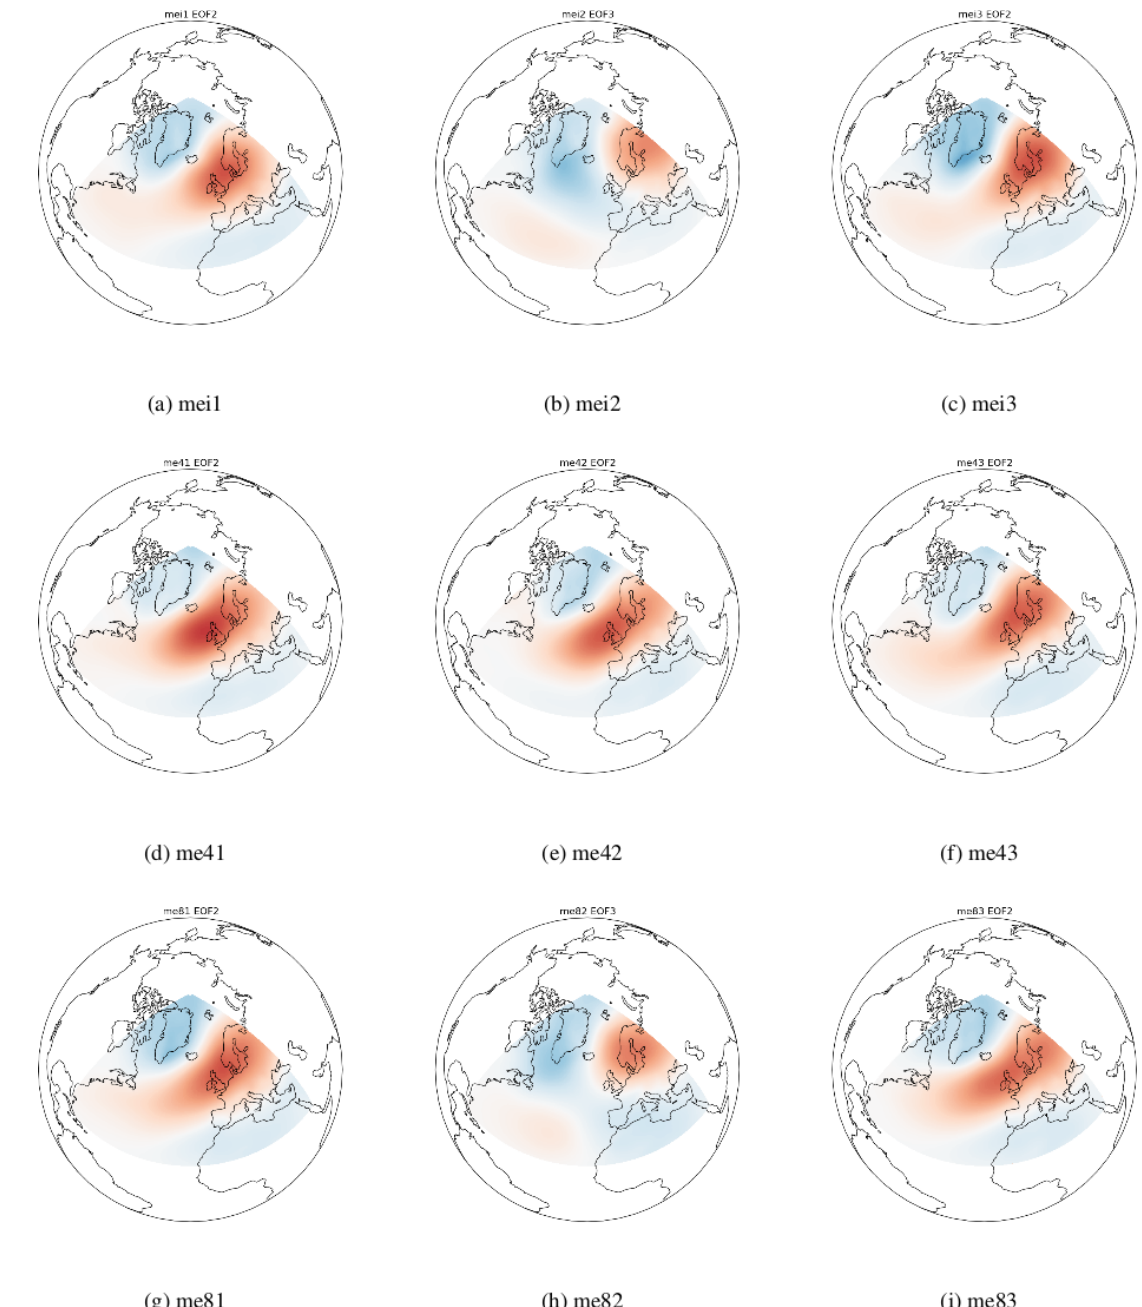
Figure A2. EOF patterns (2 or 3) corresponding to the SCAND teleconnection for the EC-Earth historical and future periods under RCP4.5 and